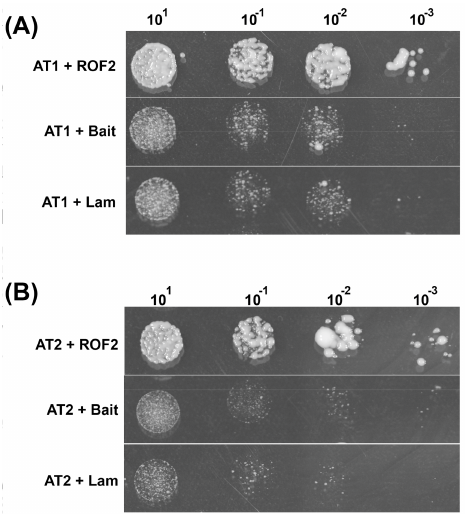
Figure 1. Cotransformation of ROF2 with AT1 ( A ) and AT2 ( B ) yeast cells (AH109 strain), and two negative controls: the empty “bait” of empty pGBKT7 vector and pGBKT7 carrying the control gene of the human protein lamin C (Lam). The initial culture of OD600 = 0.2 was used, sequentially diluted to 10 − 3